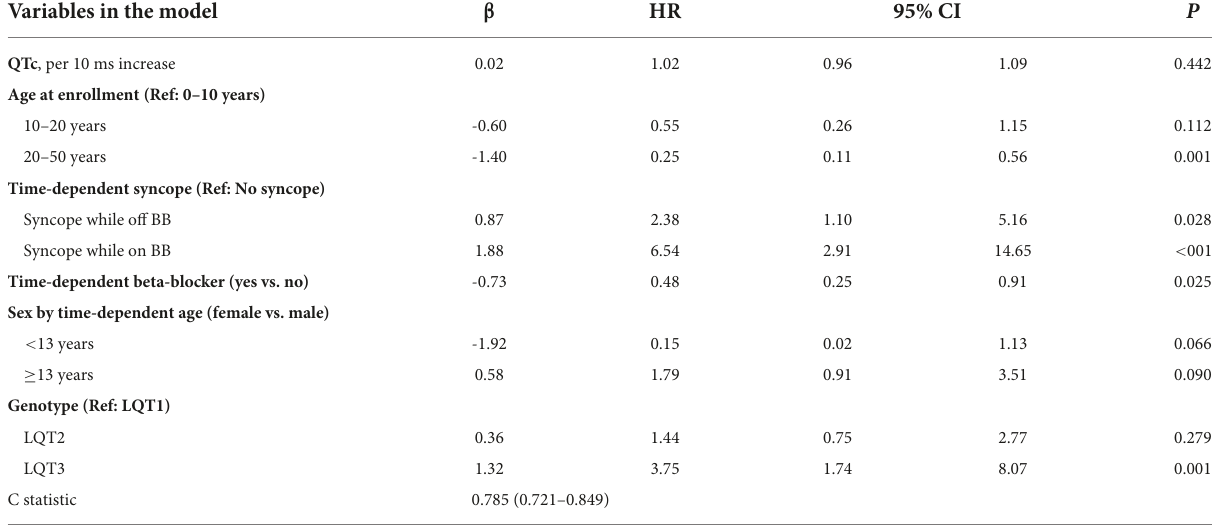
TABLE 3 Model predicting ACA, SCD, or appropriate ICD shock after enrollment in 1,288 LQTS patients with singe LQT1, LQT2, or LQT3 mutation (No. of events = 47, 14 SCD, 7 ACA, and 26 shock). Variables in the